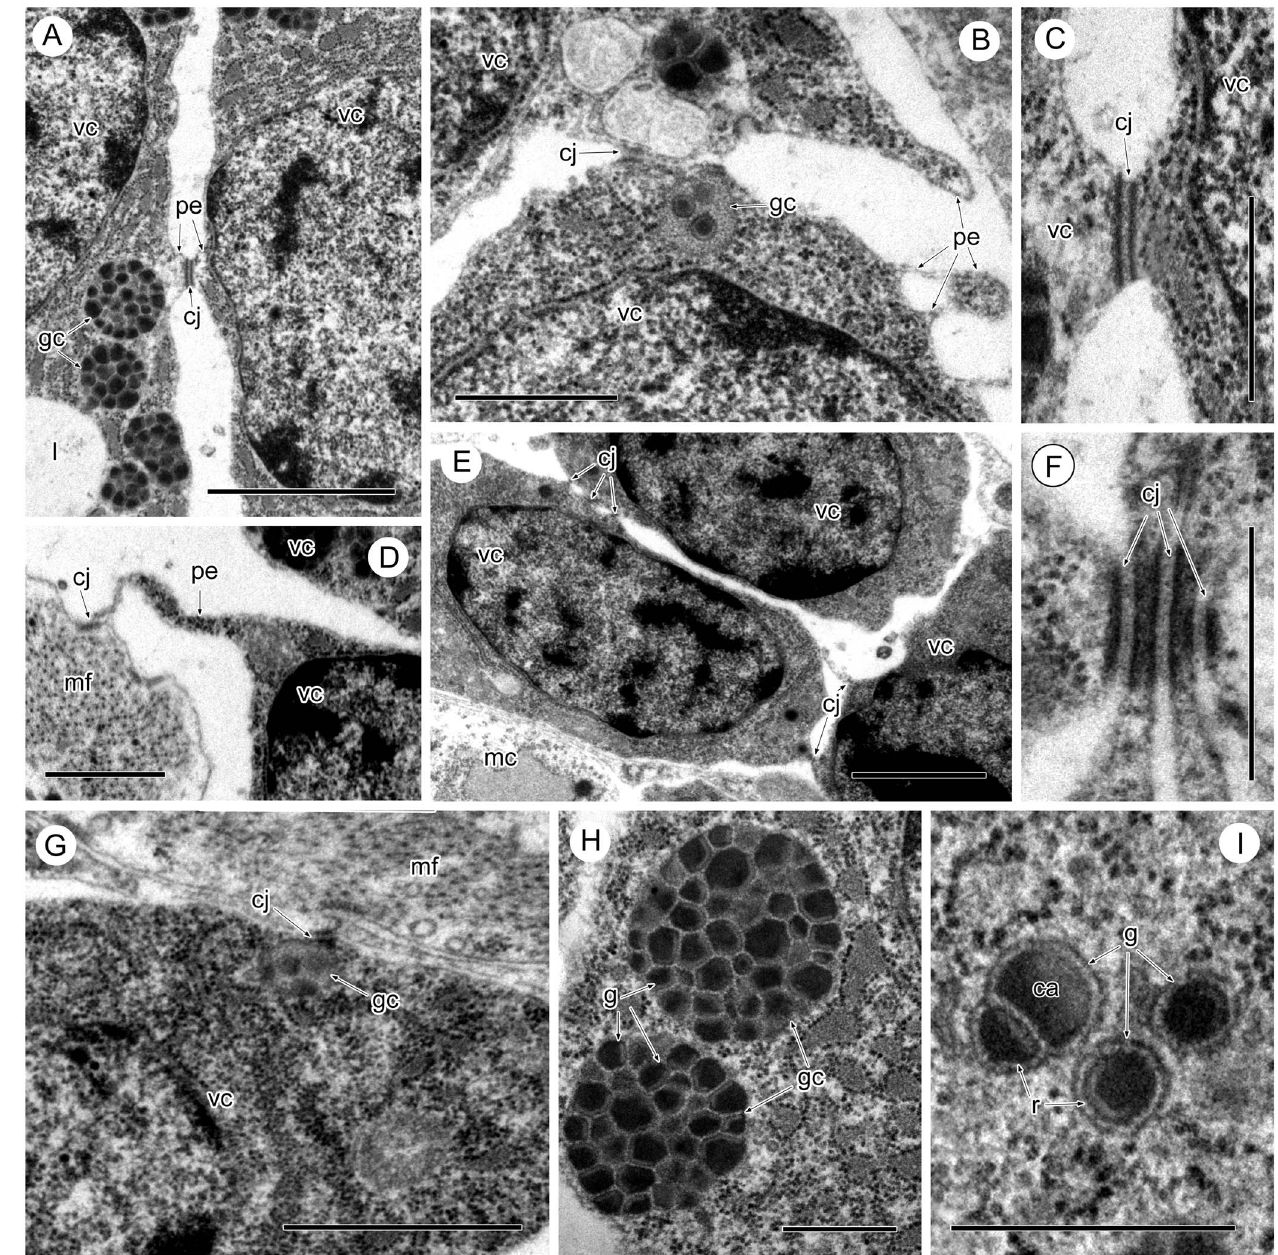
Figure 2. Intercellular junctions of the vitelline cells in Sanguinicola sp. 1 from pike. (A) Between two maturing vitelline cells, note the short cytoplasmic extension of both cells at the contact point. Scale bar = 2 l m. (B) Between two vitelline cells at an early stage of maturation, note the different kinds of pseudopodia-like extensions of the surface cytoplasm. Scale bar = 1 l m. (C, F) Detail of the junctions. Scale bars = 0.5 l m. (D) Between an immature vitelline cell and muscle fi bres, note the long cytoplasmic extension of the vitelline cell at the contact point. Scale bar = 1 l m. (E) Between immature vitelline cells. Scale bar = 2 l m. (G) Between maturing vitelline cell and muscle fi bres. Scale bar = 1 l m. (H) Vitelline clusters fi lled with vitelline globules. Scale bar = 1 l m. (I) Heterogeneous contents of the vitelline globules. Scale bar = 0.5 l m. Abbreviations: ca = central area of vitelline globule, cj = cell junction, g = vitelline globule, gc = globular cluster, mc = muscle cell, mf = muscle fi bres, pe = pseudopodia-like extension, r = lucid rim of vitelline globule, vc = vitelline